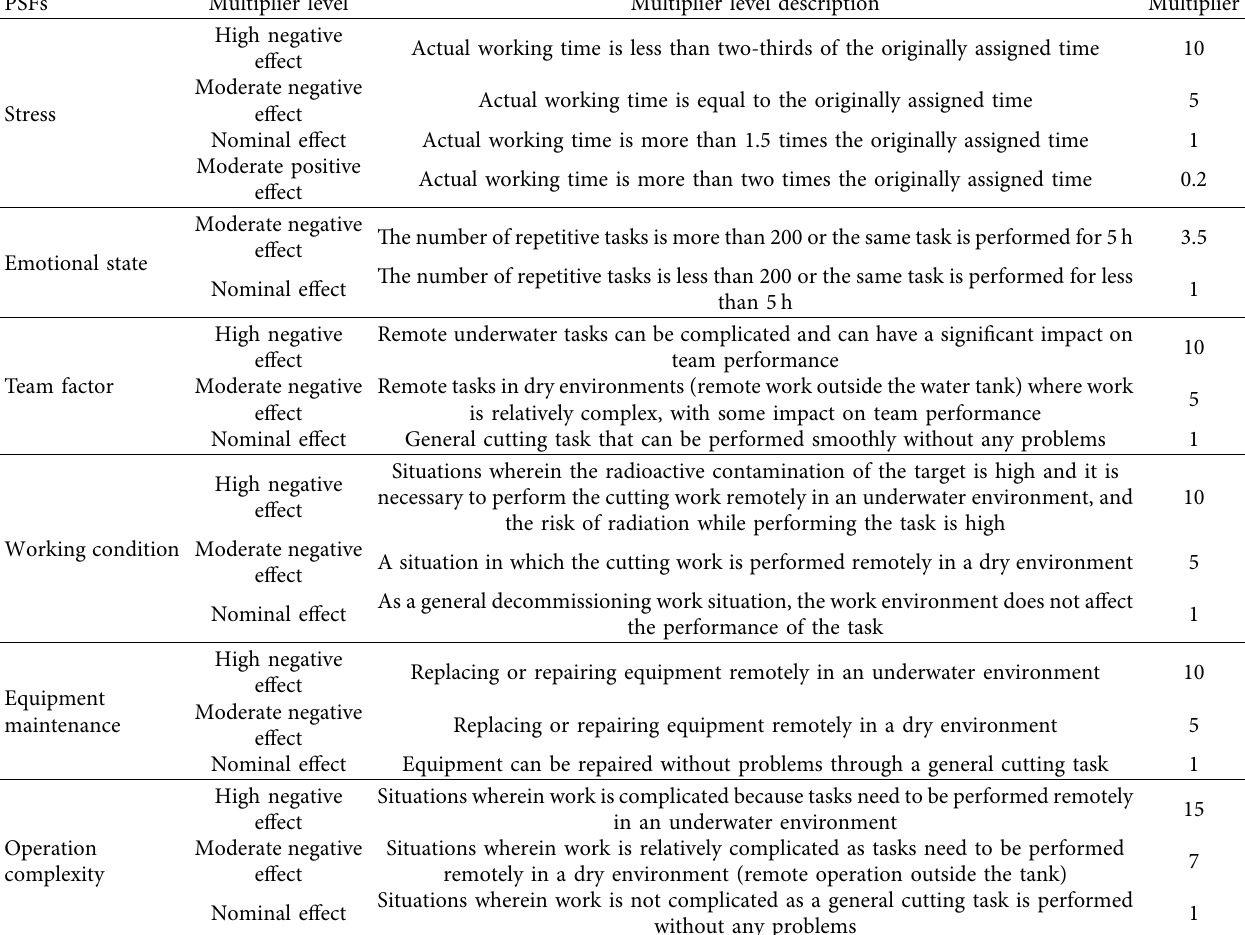
Table 3: Multipliers for the PSFs of NPP